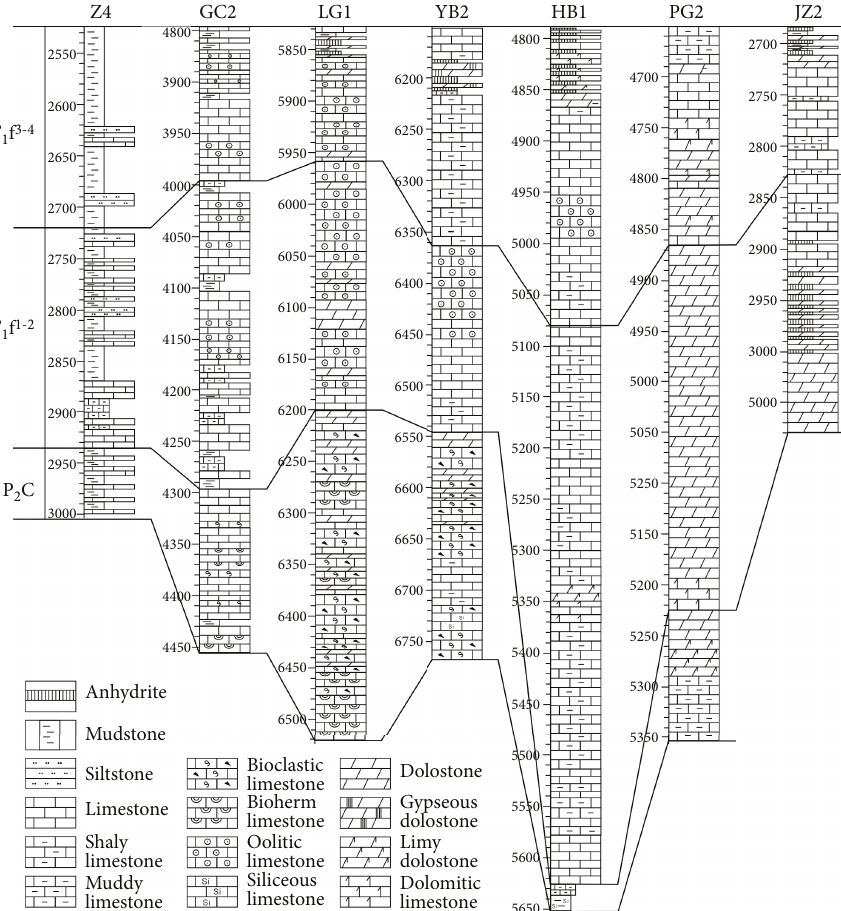
Figure 3: The lithologic variations in the Changxing (P northeast. The data for wells Z4, GC2, LG1, and JZ2 are from Du et al. [24]. The fi gures to the left of each lithologic column are the burial depths (in m). T f 1 – 2 =the fi rst and second members of T 1 Figure